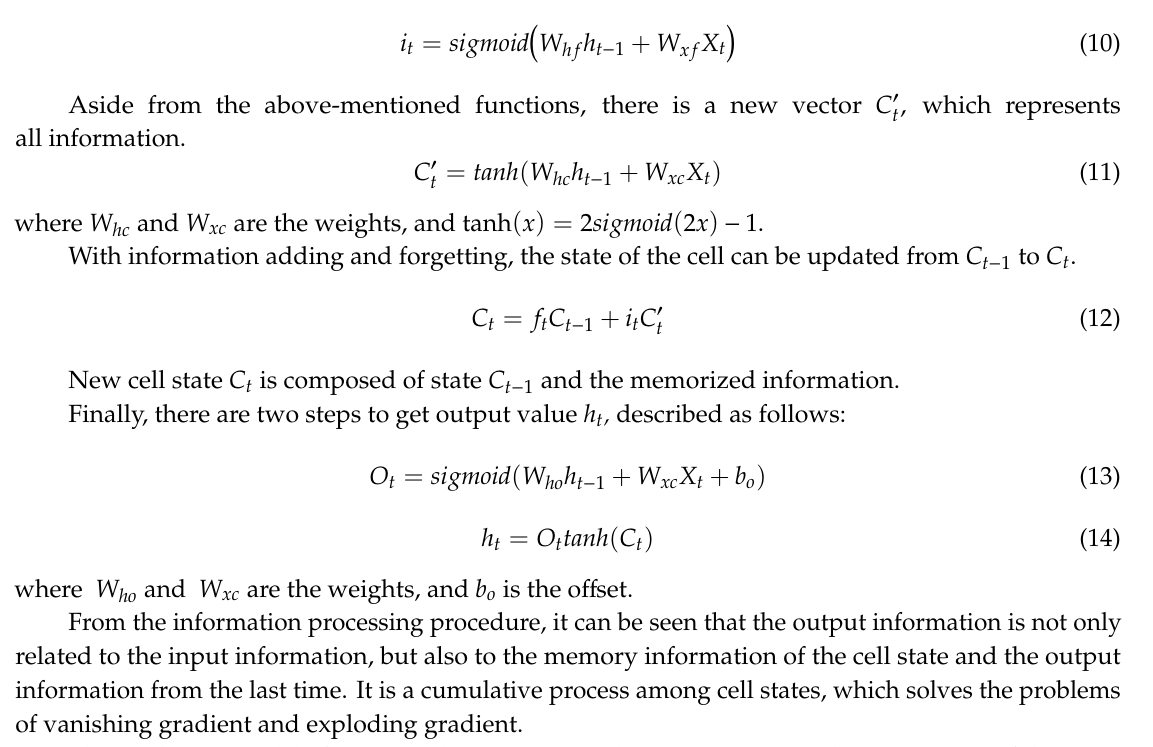
Figure 4. Structure of the long short-term memory (LSTM) algorithm.